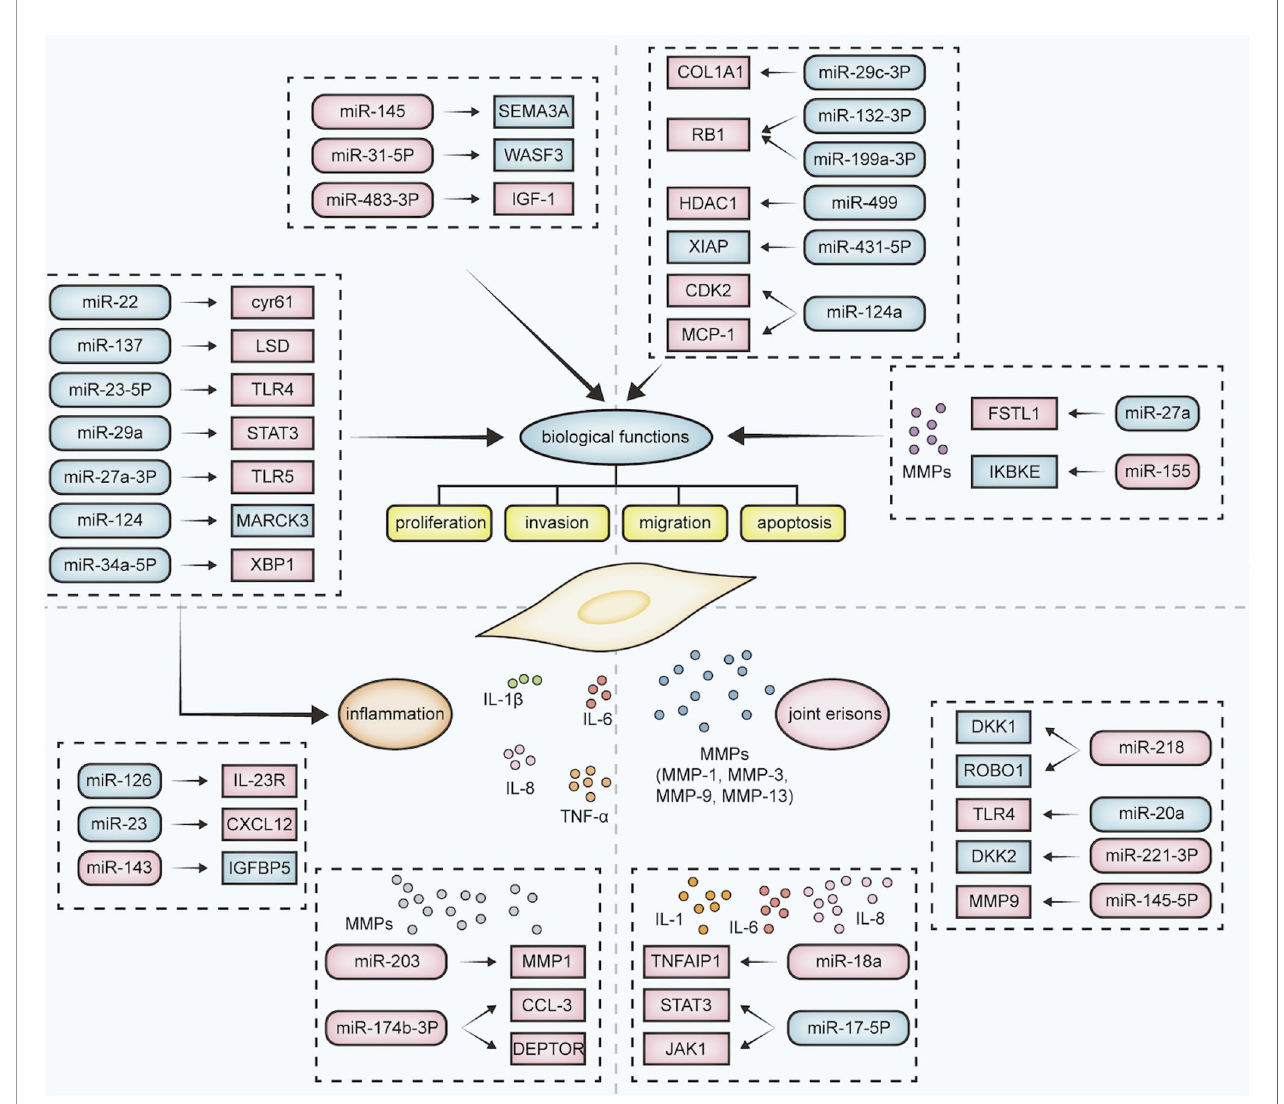
FIGURE 1 | Effects of dysregulation of the miRNA-mRNA network on RA-FLS. The dysregulation of miRNAs and their target mRNAs in RA-FLS affects the biological function (such as proliferation, invasion, migration, and apoptosis), in fl ammatory levels, and joint bone destruction. In fl ammatory levels are mainly related to the release of in fl ammatory factors such as IL-8, IL-6, and joint bone destruction is mainly related to the release of MMPs. Dysregulation of different miRNA-mRNA combinations affects different processes in RA-FLS. Rounded rectangles represent miRNAs; rectangles represent target mRNAs; pink represents upregulation; blue represents